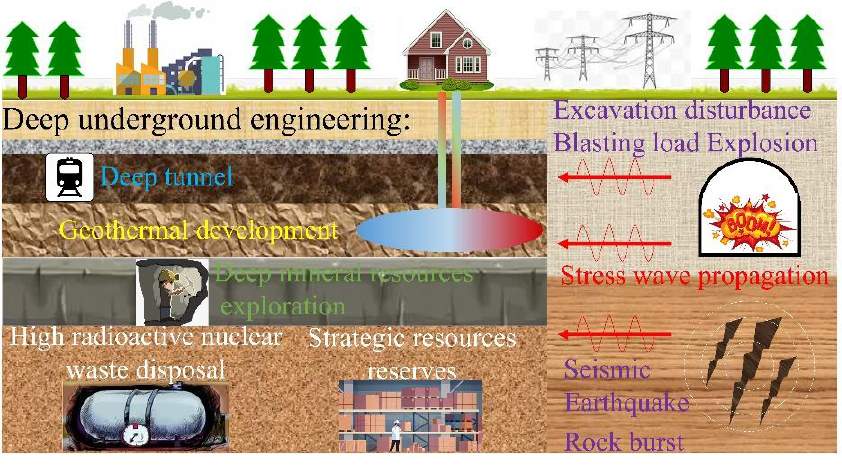
Figure 1. Overview of deep underground engineering.